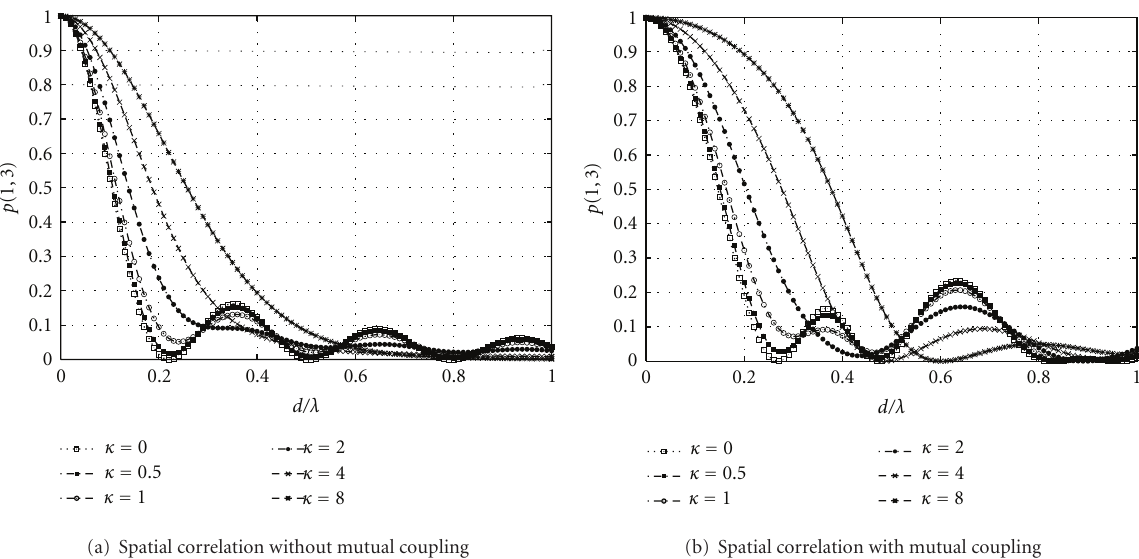
Figure 5: Spatial correlation between elements 1 and 3 for a circular array with six elements, and di ff erent values of the parameter κ , with φ p = 60 ◦ , as a function of a/λ